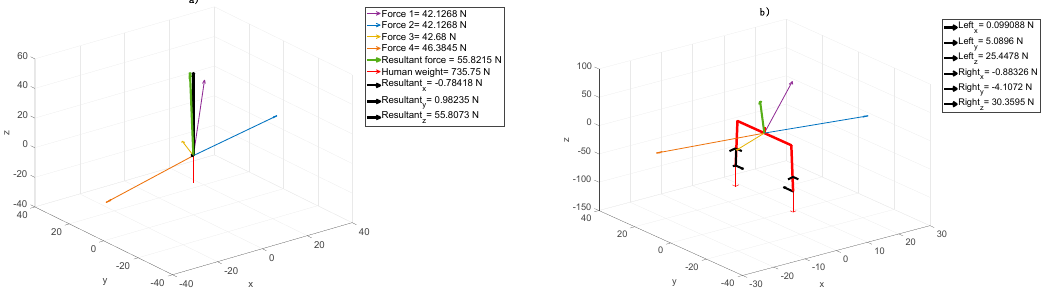
Figure 4. Elastic cord force values in the SPIDER cage in case of a human with a mass of 75 kg and the following setup: ( a ) cord elongations 1 and 2—250 mm, 3—240 mm, and 4—310 mm; COG level angle cords 1 and 2—45 ◦ , 3—6 ◦ , and 4—48 ◦ ; ( b ) elastic cord forces and foot reaction values in the xyz directions.